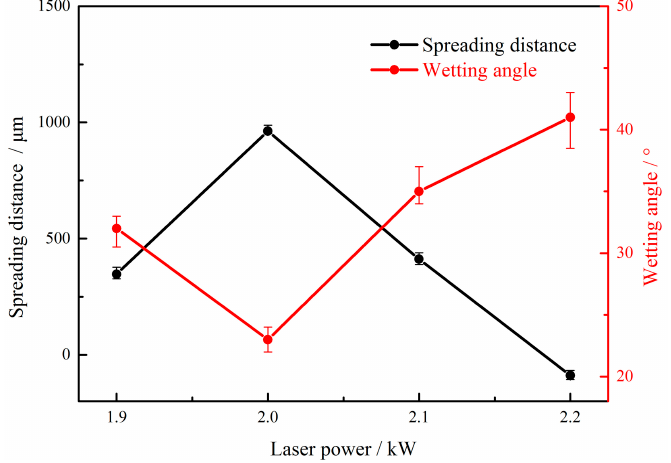
Figure 6. Spreading distance and wetting angle with different laser powers.